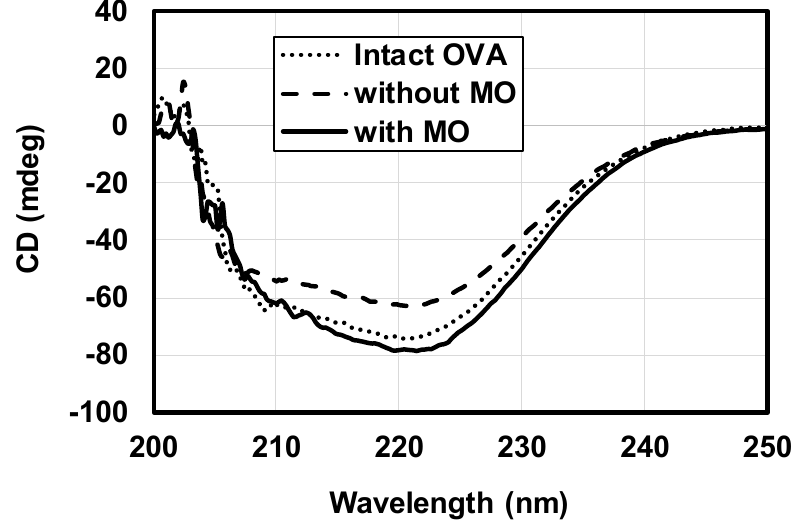
Figure 3. Circular dichroism spectra of intact ovalbumin (OVA) in PBS, and the OVA released from the oil dispersions with or without monoolein (MO) ( n = 3).